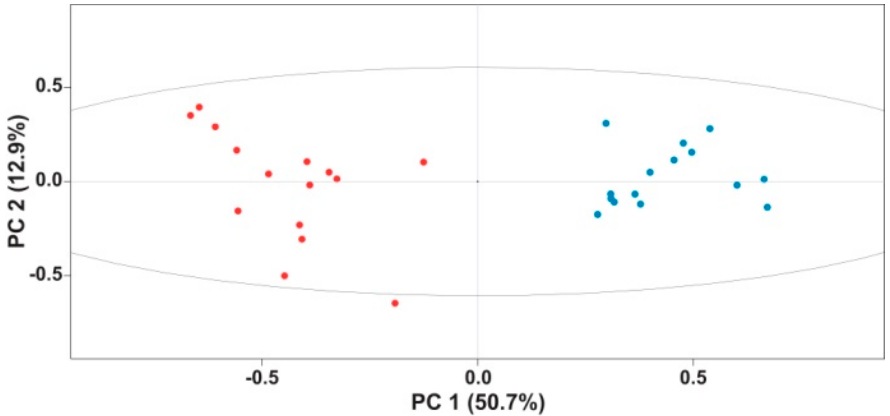
Figure 2. Principal component analysis (PCA) score plot of 1 H- 13 C HSQC regions of interest (ROIs). D 2 O extracts of herbivore (blue dots) and cannibal (red dots) Helicoverpa armigera larvae formed two distinct groups.